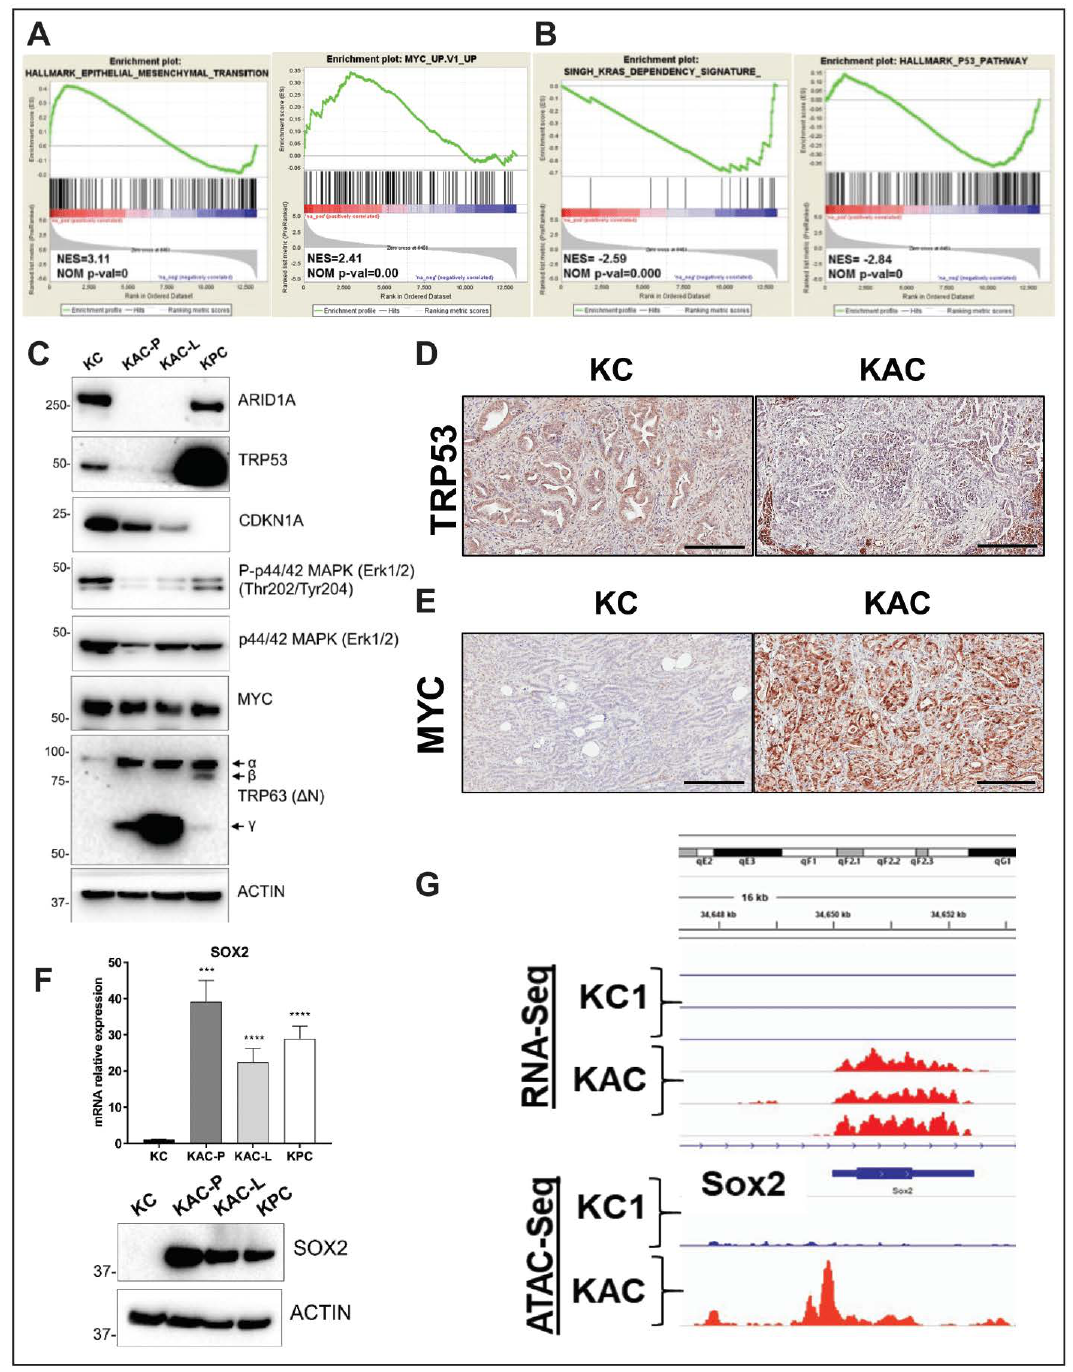
Figure 5. Identification of oncogenic mechanisms in “KAC” PDAC cells. ( A , B ) Representative plots from GSEA analysis of di ff erentially expressed genes (2-fold change) identified from RNA-seq on “KC” and “KPC-P” cells revealed positive enrichment in hallmark of EMT and Myc target genes and negative enrichment in Kras dependency gene signature and hallmark P53 pathway. ( C ) Immunoblotting on protein lysates from autochthonous mouse PDAC cell lines showed loss of ARID1A and TRP53 expression in “KAC” cells along with reduction in levels of CDKN1A (p21) and phospho-Erk1 / 2. While total MYC levels were unchanged in all lines, “KAC” cells showed high levels of Trp63 ( δ N) isoform γ as compared to “KC” and “KPC” cells. ( D – E ) Representative microscopic images of IHC for TRP53 and MYC on PDAC sections from > 1-year old “KC” and “KAC” mice showed focal loss of p53 expression and strong expression of MYC in ARID1A-negative “KAC” group. Scale bar is 100 µ